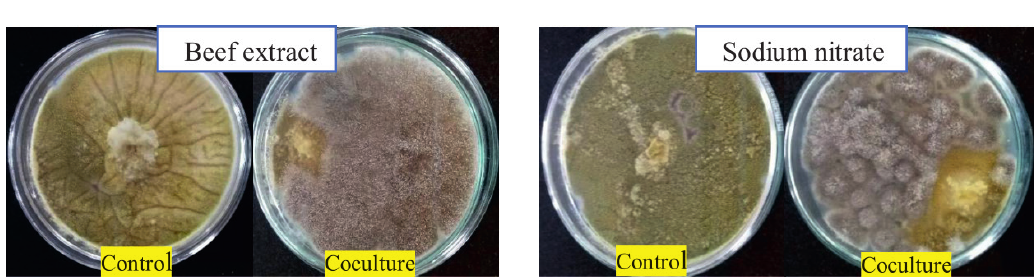
Fig. 7. Overgrowth of A. giganteus over pathogenic A. flavus during coculture in media with Beef extract as organic nitrogen source and sodium nitrate as inorganic nitrogen source